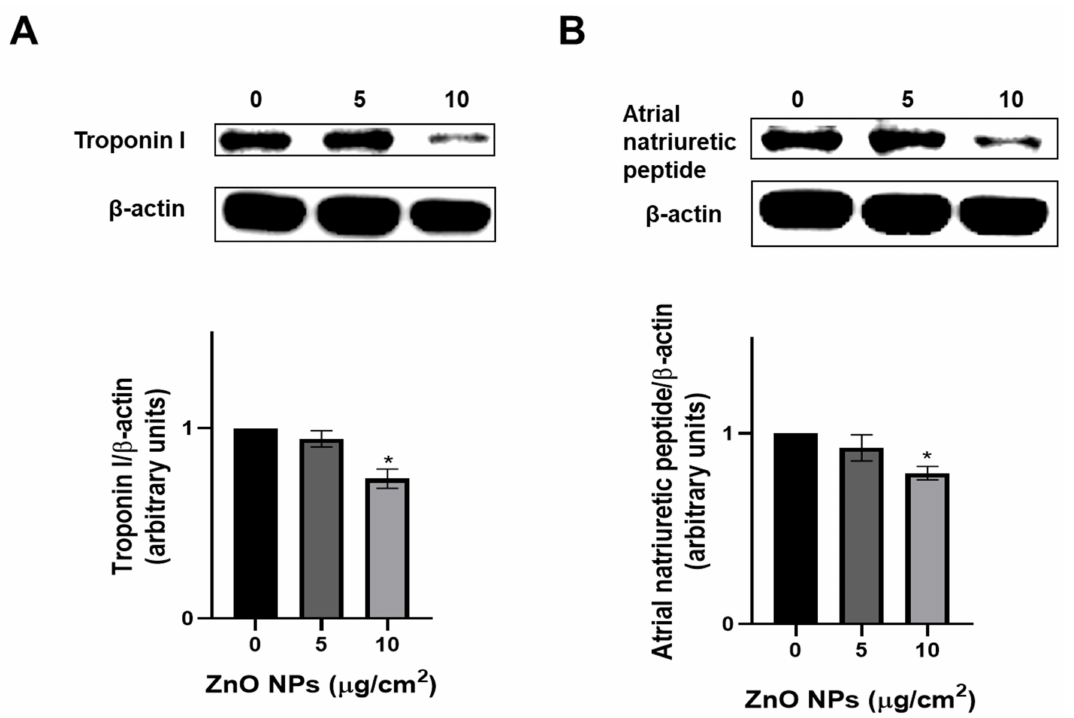
Figure 10. ZnO NPs effect on cardiac protein expression. Cells (1 × 10 6 ) were exposed to 0, 5 and 10 µ g/cm 2 over 48 h, and the expression of troponin I ( A ) and atrial natriuretic peptide ( B ) was determined by western blot. A representative experiment is shown where β -actin was used as load control. Densitometric analysis of protein expression normalized against β -actin levels are showed below, and results are expressed as mean ± standard deviation of three independent experiments. * p < 0.05 compared with